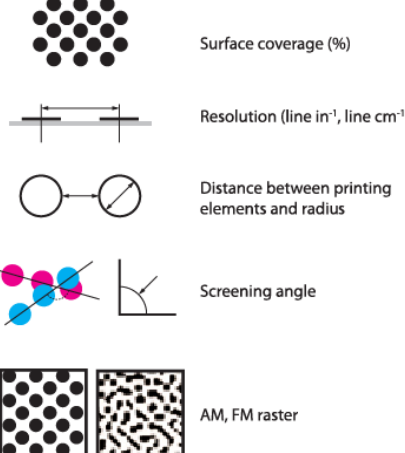
Figure 3. Quality defining parameters on offset printing